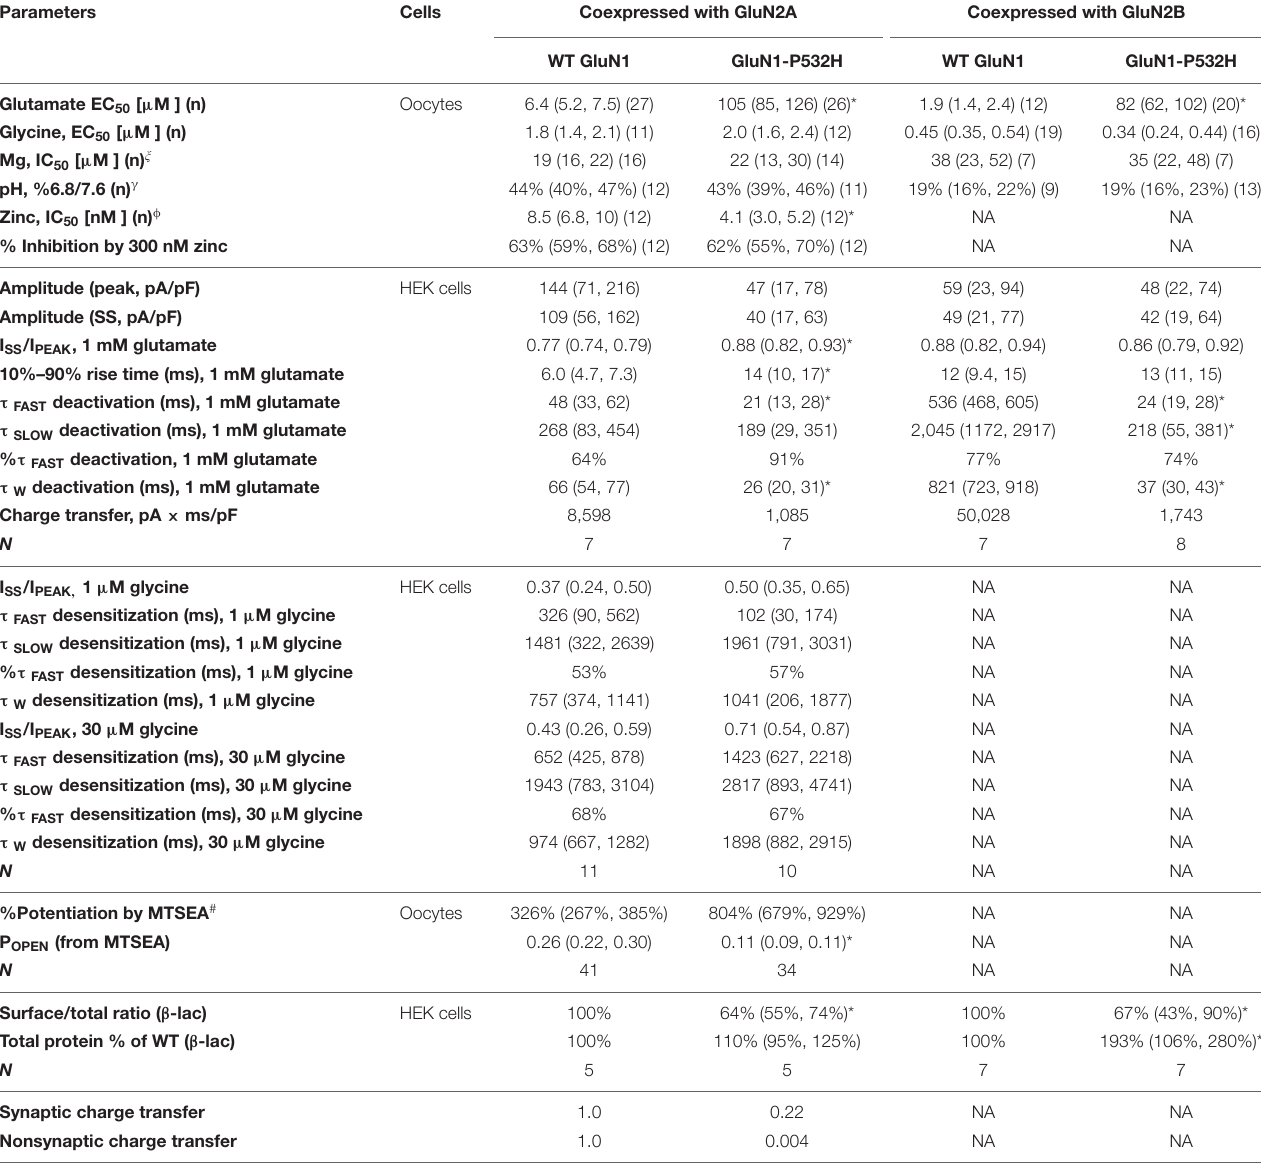
TABLE 1 | Summary of functional properties of GluN1-P532H-containing receptors. Parameters